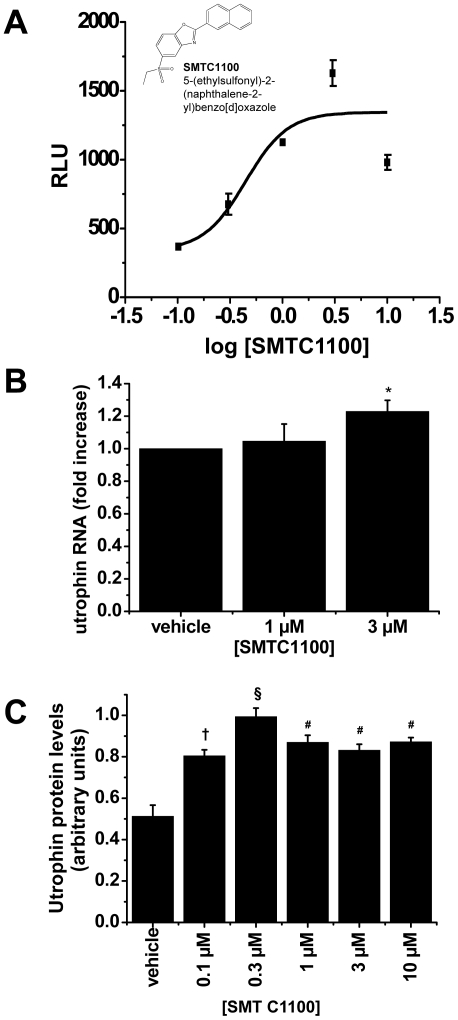

In vitro activity of SMT C1100.(A) SMT C1100 dose response in murine H2k-mdx utrnA-luc
cells expressing the human utrophin promoter linked to a luciferase
reporter gene. Cells were treated with compound for 48 h in standard
growth medium containing 0.3% DMSO. The chart shows relative
luminescence (RLU) in relation to five different doses of SMT C1100. A
Four Parameter Logistic Model was used to generate an EC50.
Points represent a mean ±S.E. of three experiments and are
typical of the results for all batches of SMTC1100. The structure for
SMTC1100 is shown; (B) SMT C1100 significantly increased mRNA copy
number of the utrophin transcript in SkMC cells. In this assay Gene
Expression Assay 4326315 was used for β-actin detection and Gene
Expression Assay Hu01125984_m1 was used for utrophin transcript
detection (both Applied Biosystems). Cells were exposed to SMT C1100 in
standard media with 1% DMSO (vehicle) for 72 hours with six
biological replicates. *p = 0.01 relative to
vehicle only; (C) Utrophin protein levels in human DMD cell line treated
with SMT C1100 (1 µM) or vehicle (0.1% DMSO). Blots were
stained with anti-utrophin (MANCHO3; 1∶100) and ECL HRP-conjugated
anti-mouse antibody (GE Healthcare). Bands were quantified using Image J
and arbitrary units represent utrophin levels corrected for equal
loading by α-actinin immunostaining. Results represent a mean
± S.E based on n = 3.
†p = 0.00683; §p<0.001; #p<0.005
relative to vehicle-treated cells.